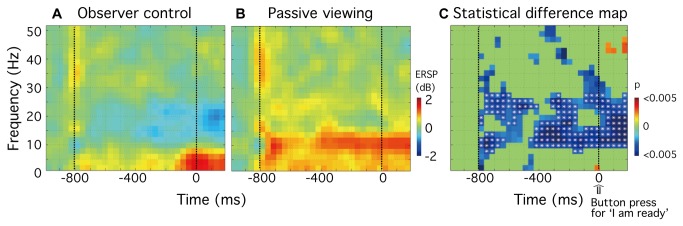
Group analysis (n=10) showing the differences between experimental conditions for the time-locked-to-button-press data set in left IPL.
A and B, The group-mean ERSP plots show power differences (in dB) referenced to a 300 msec baseline recording for (A) observer-control and (B) passive viewing conditions. C, Statistical significance map of the differences between the experimental conditions, as assessed using a paired-sample t test (n = 10, p < 0.05). Multiple comparisons were corrected for 7.8 Hz to 27.3 Hz, and results are indicated as white asterisks in Panel C (p < 0.05, FDR corrected; df = 9).